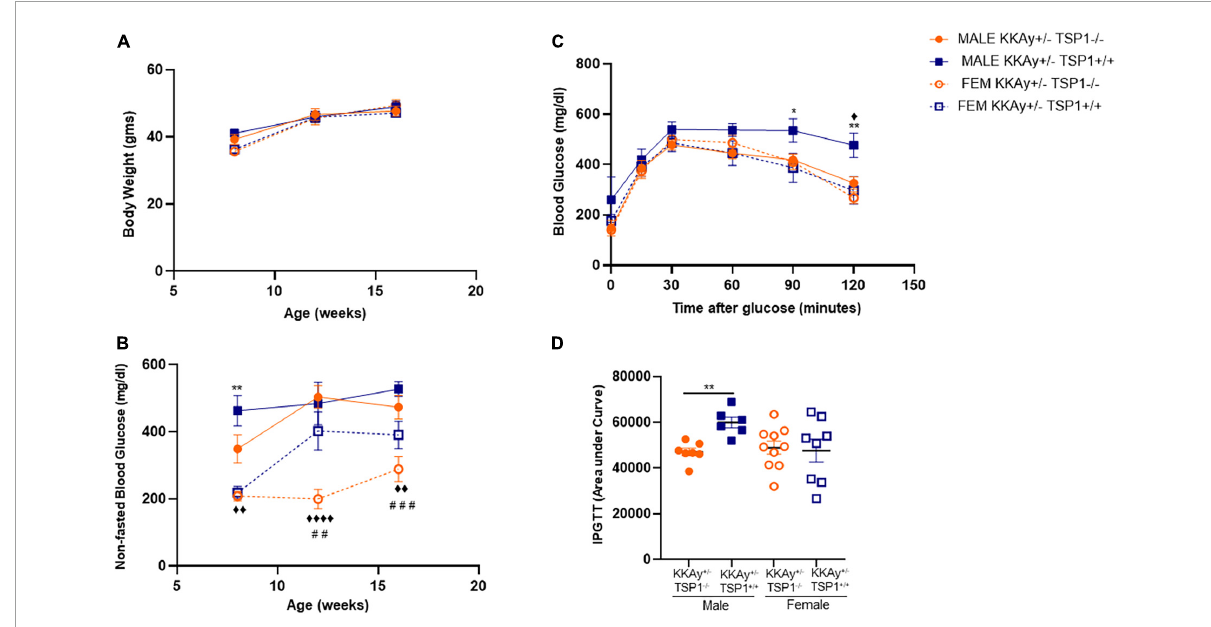
FIGURE6 Effect of global TSP-1 deletion on metabolic profile of MetS KKAy + / − mice. Male and female age-matched agouti KKAy + / − TSP-1 + / + and KKAy + / − TSP-1 − / − littermate mice were maintained on standard lab diet from 4 to 18 weeks of age. Shown are (A) body weight and (B) non-fasted blood glucose levels measured in subsets of mice genotypes of each sex at 8-, 12- and 16-weeks-age. (cid:7) p < 0.005, (cid:7)(cid:7)(cid:7)(cid:7) p < 0.0001 denotes male KKAy + / − TSP-1 − / − vs. female KKAy + / − TSP-1 − / − ; ** p < 0.005 denotes male KKAy + / − TSP-1 + / + vs. female KKAy + / − TSP-1 + / + ; ## p < 0.005, ### p < 0.0005 denotes female KKAy + / − TSP-1 + / + vs. female KKAy + / − TSP-1 − / − . (C) glucose tolerance test (GTT) done at 17 weeks age. * p < 0.05, ** p < 0.005 denotes male KKAy + / − TSP-1 + / + vs. female KKAy + / − TSP-1 + / + , (cid:7) p < 0.05 denotes male KKAy + / − TSP-1 + / + vs. male KKAy + / − TSP-1 − / − . (D) Area under curve for GTT. n = 7–10 per genotype per sex for panels (B,C) ; n = 5–10